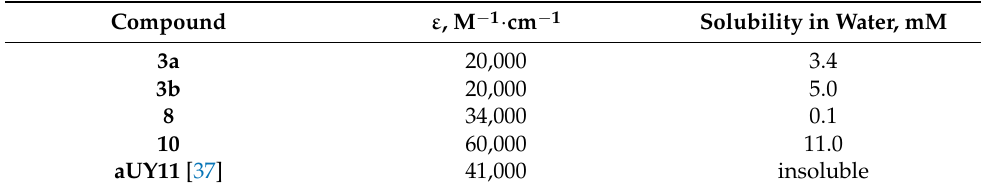
Table 2. Solubility of perylene-based compounds in